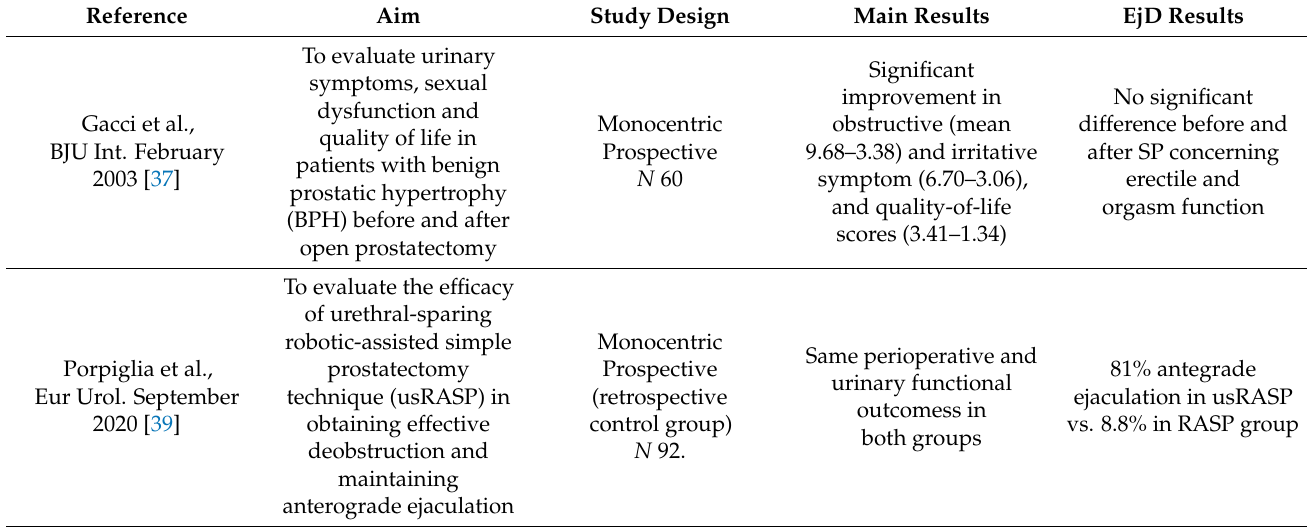
Table 6. Impact of simple prostatectomy on ejaculatory